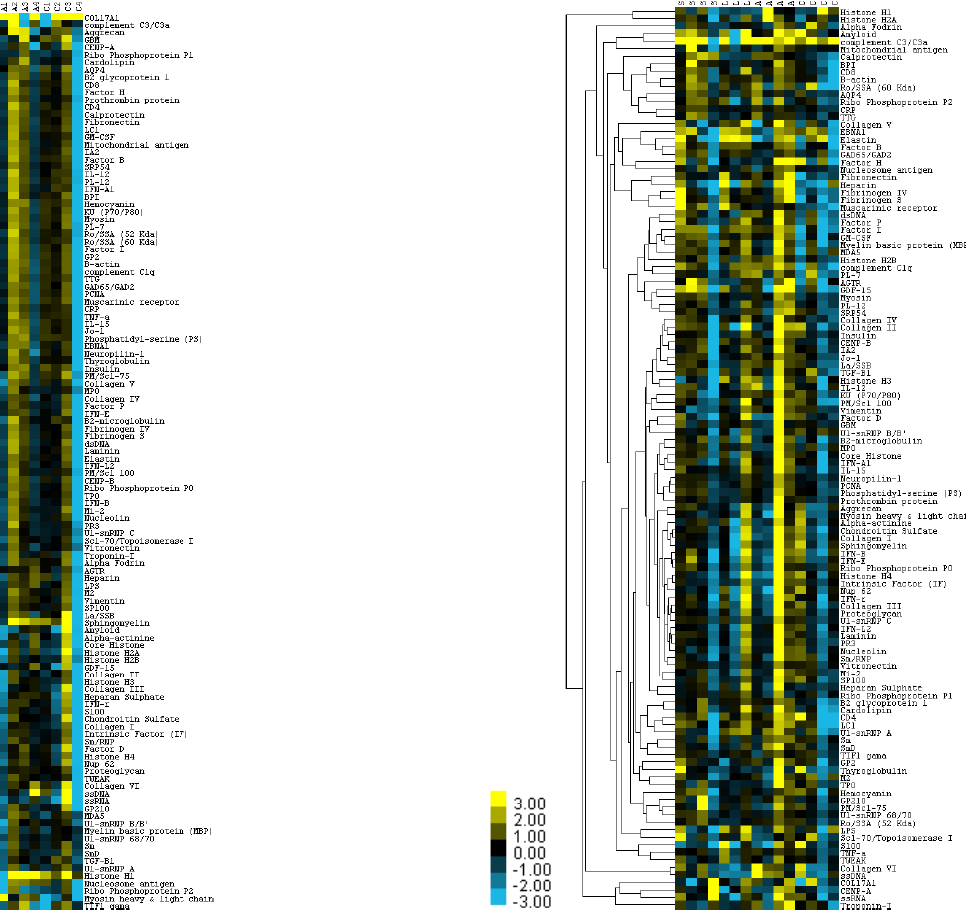
Figure 4. Heatmap of IgM and IgG autoantibodies overrepresented in vaccinated infected cohorts. According to the NSI-nor value, log2 (NSI+1) is calculated, the data are normalized, and a heat map is generated. The antigens are clustered according to Euclidean distance. Additional information is in Supplementary Materials Data File S3. Abbreviations: S, severe; L, non-severe: A, asymptomatic; C, PCR – (Table 1).